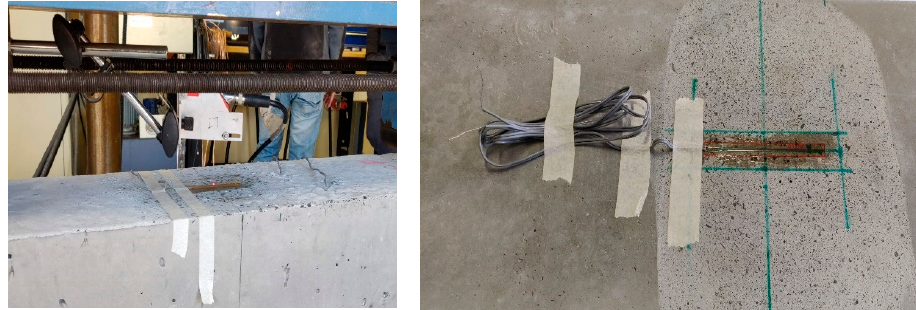
Figure 5. Test setup—loading span, laser extensometer, and strain gauge.